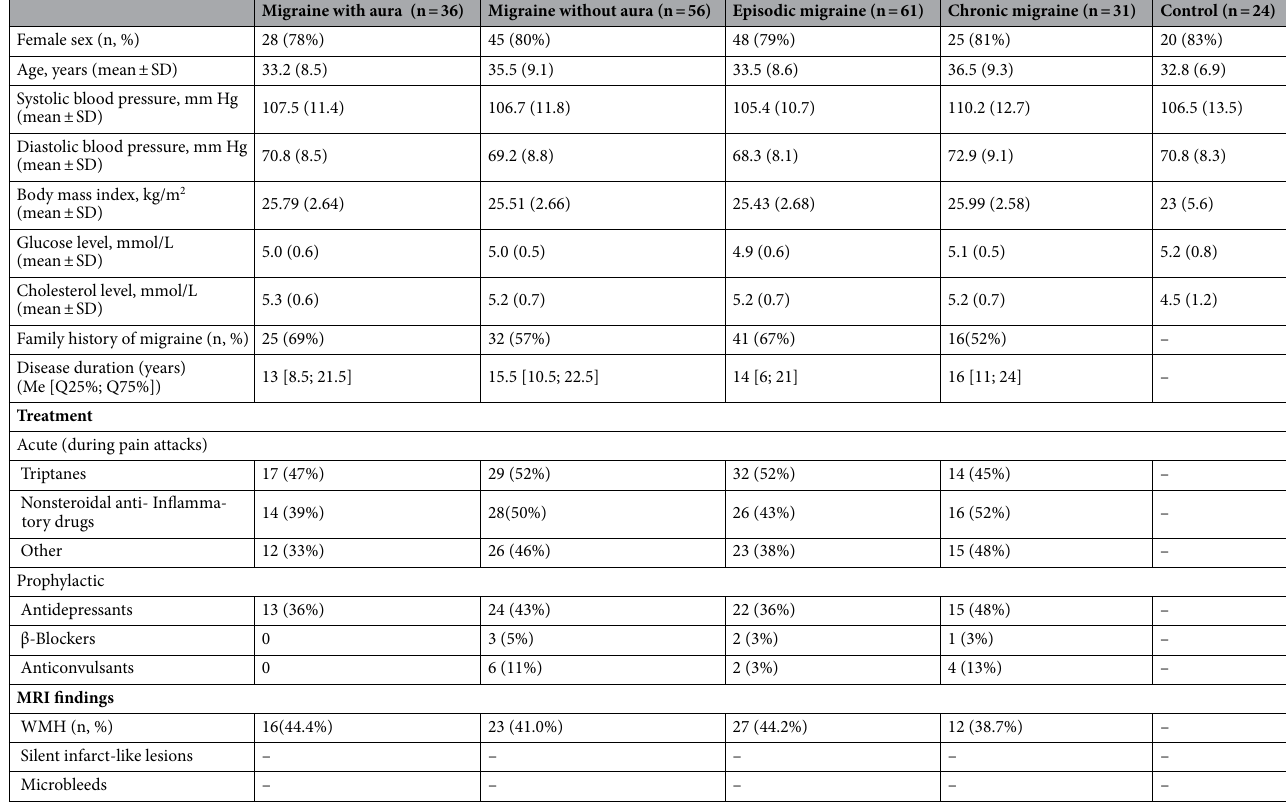
Table 1. Characteristics of migraine patients and subjects of the control group; there were no significant